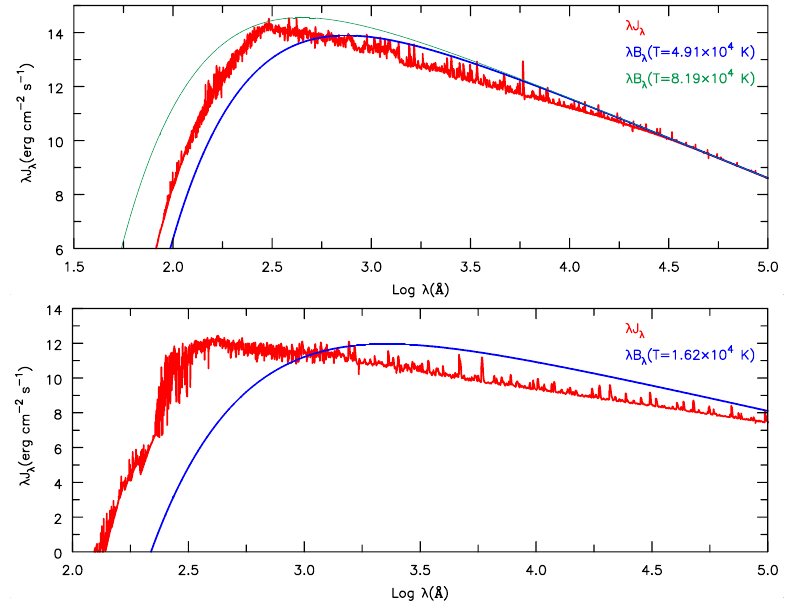
Figure 10. An illustration of the radiation field in a WC4 star at a depth where V ( r ) = 0.67 × V ∞ ( N e = 1.7 × 10 13 cm − 3 ) (top panel) and at a depth V ( r ) = 0.934 × V ∞ ( N e = 1.2 × 10 11 cm − 3 ) (lower panel). Shown also is the blackbody spectrum at the local electron temperatures ( T e = 4.90 × 10 4 K and T e = 1.61 × 10 4 K). In the top panel (where V ( r ) = 0.67 × V ∞ ) we also illustrate the blackbody spectrum at the effective temperature ( T e = 8.19 × 10 4 K) that has been normalized to match the model spectrum at 5.0 µ m. As readily apparent, the local radiation field is very different from that defined by the blackbody at the local electron temperature or that defined by the effective